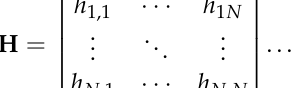
where H is the channel matrix, and W is the sum of thermal noise and ambient shot light noise, which is independent of the transmitted signal, as indicated in [20]. Therefore, the entries of W are composed of a zero-mean additive white Gaussian noise (AWGN) in real numbers with the following variance: